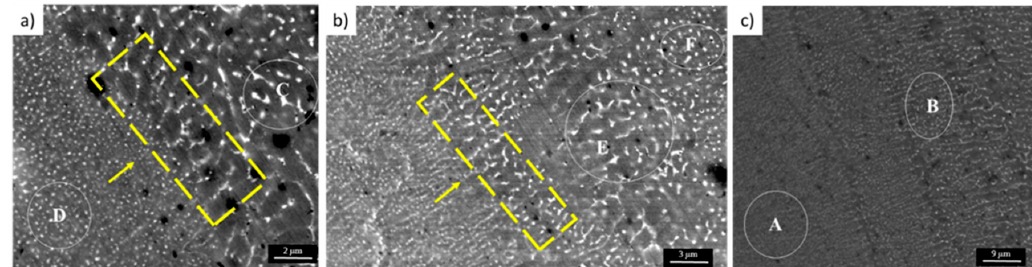
Figure 8. High magnification SEM images of the deposit cross-section showing some different areas inside the deposit. Yellow arrows indicate the microstructure in the layer-layer interfaces. ( a ) circles C and D highlighted the different microstructures in the different layers, ( b ) circle E shows dendrites with mixed morphology while the circle F shows uniform distribution of fine second phase particles inside the same layer, ( c ) circles A and B highlight the same cellular dendritic microstructure in different layers. Appl. Sci. 2017 , 7 , 945